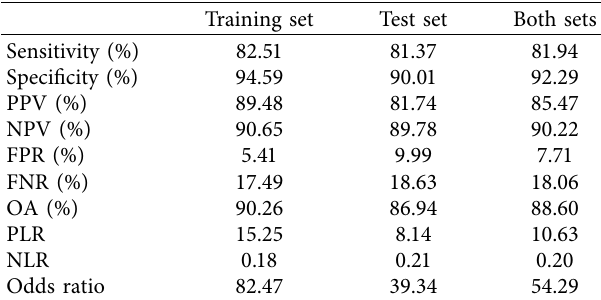
Table 5: Performance indices for the RBF ANN for the training and test sets and for both sets combined.